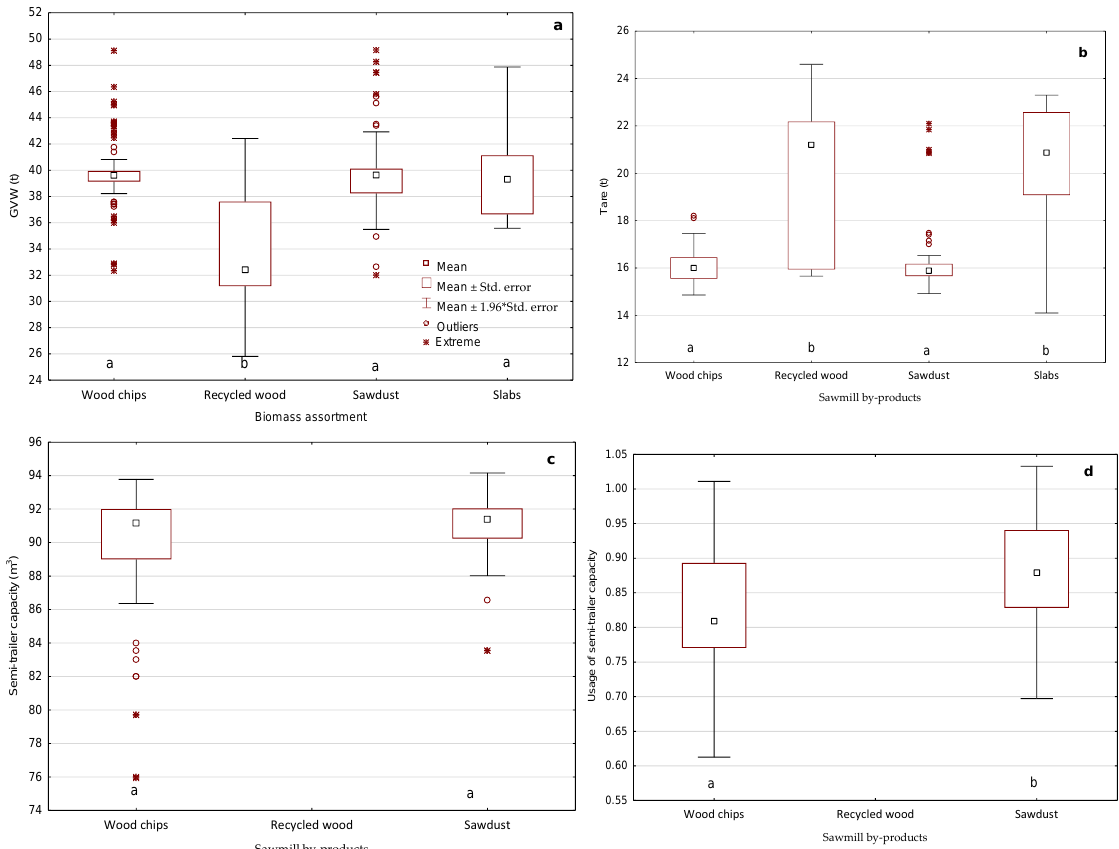
Figure 4. Characteristics of the transport sets depending on the sawmill by-product assortment: ( a ) GVW, ( b ) tare, ( c ) semi-trailer capacity, ( d ) usage of the semi-trailer capacity. Groups with dissimilar lower-case letters (a,b, over the x -axis) indicate significant differences, according to a Kruskal – Wallis test or Dunn ’ s multi-sample rank mean comparison test. There are statistically significant differences ( p = 0.00) for bulk cubic meter (Figure 5a) and the usage of the semi-trailer (Figure 4d), where no similarities were found. The cargo weight is similar for the transports of sawdust, woodchips, slabs and recycled wood (Figure 5b). The trailer capacities for wood chips and sawdust transports are similar at p = 0.995, based on the Kruskal – Wallis test (Figure 4c).